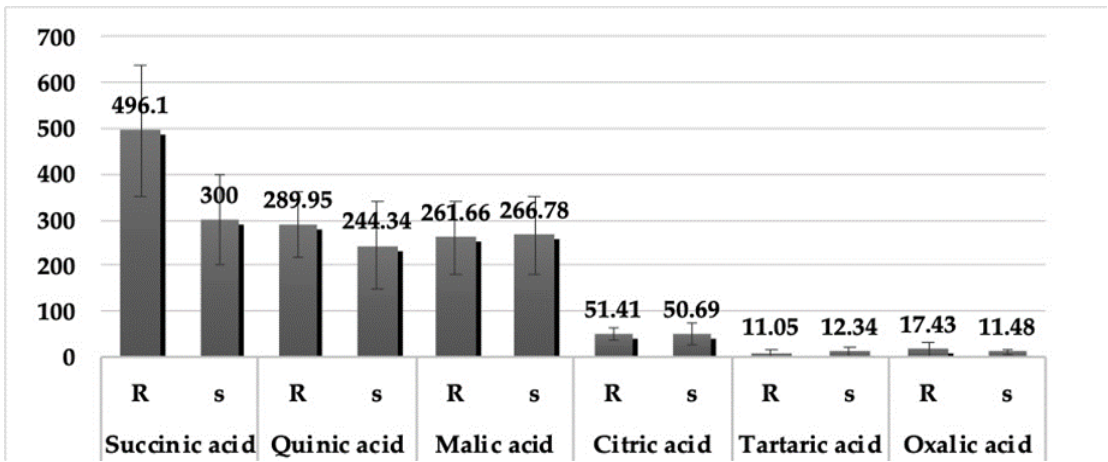
Figure 3. Organic acid content in resistant (R) and susceptible (s) RILs of chickpea. Bars indicate means ± standard errors.